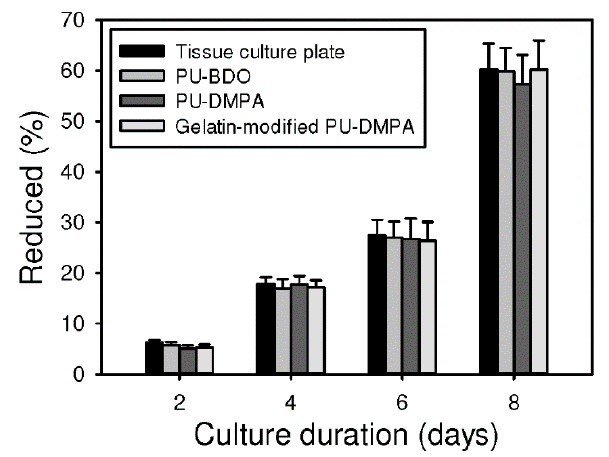
Figure 6. Growth of HUASMCs cultured alone in tissue culture plates, with the PU-BDO, PU- DMPA, and gelatin-modified PU-DMPA, respectively, in terms of the percentage of reduced Ala- mar